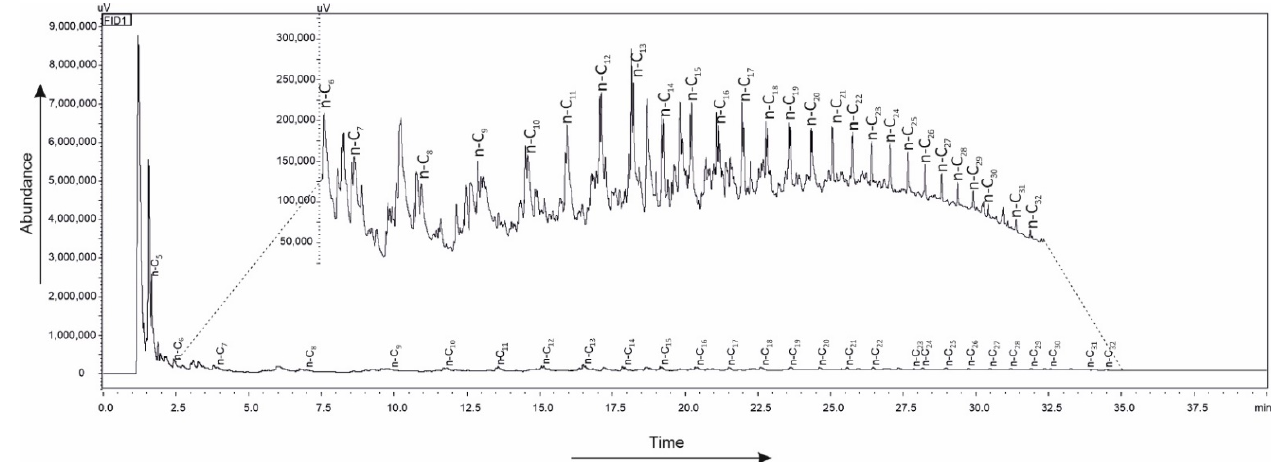
from the Istebna Beds.